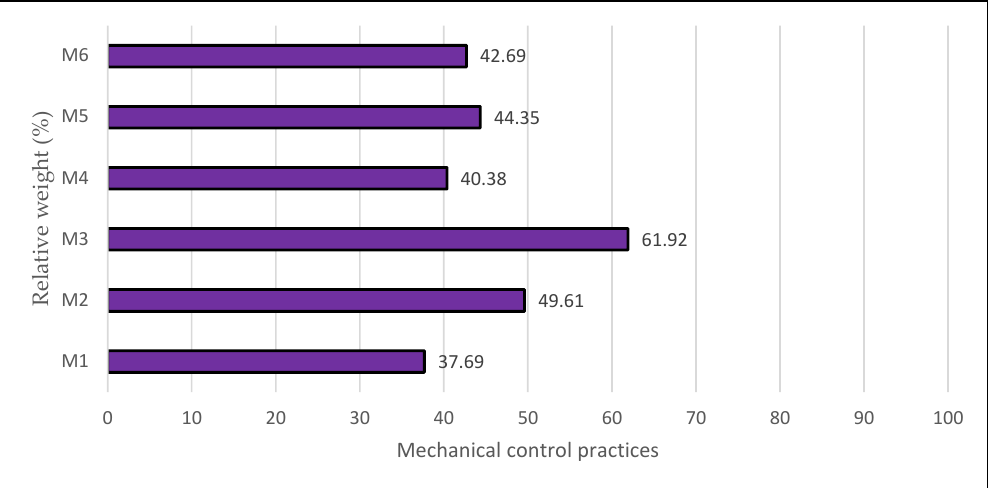
Figure 5. Farmers’ adoption of mechanical control practices for red palm weevil control. (M1 = covering roots of small trees with soil to a height of 20 cm to prevent insect attacks, M2 = removing weeds and dry trunks and disposing of them in the recommended way, M3 = eradicating infested palms, M4 = removing infested or dead trees and the pruning products on neglected farms, M5 = closing all openings on the trunks of palms, M6 = scraping infested areas until healthy tissue is exposed).